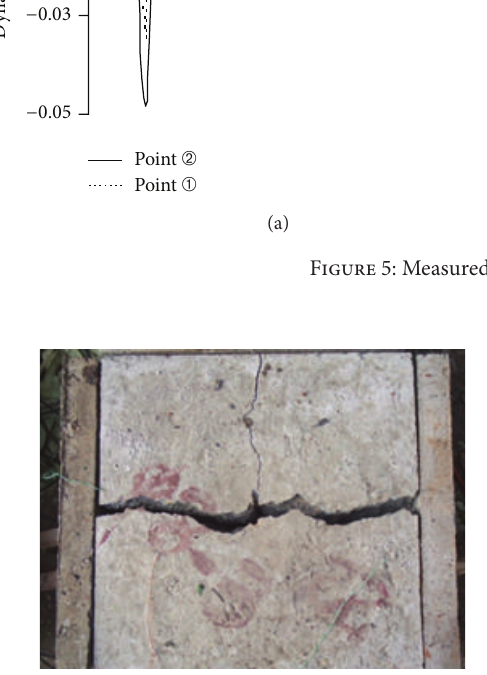
Figure 6: Distribution of blasting cracks in the 𝜙8 mm model.